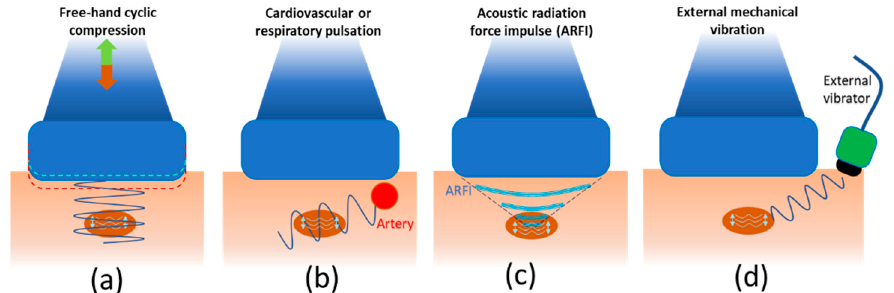
Figure 5. Strain ultrasonography techniques categorized by their excitation methods (generating pressure wave sources) to induce strain in the tissue of interest. ( a ) Free-hand cyclic compression (palpation), ( b ) cardiovascular or respiratory pulsation, ( c ) acoustic radiation force impulse (ARFI), and ( d ) external mechanical vibration have been used as excitation sources in strain ultrasonogra- phy.